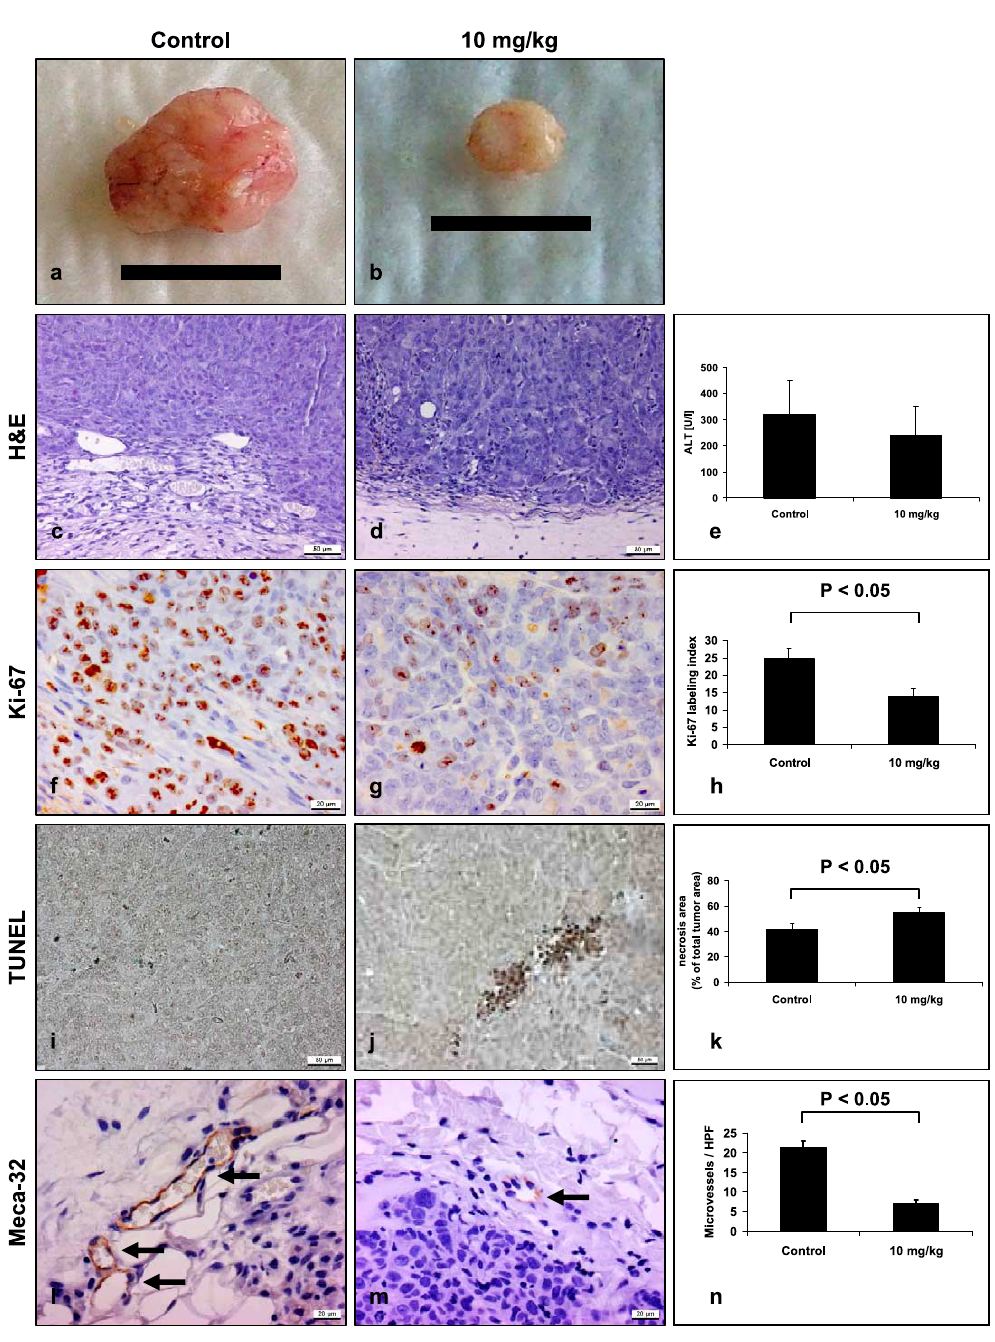
Fig. 6. Morphologic analysis of HepG2 xenografts treated with panobinostat. Representative tumors are shown from vehicle treated controls (a) or animals receiving daily i.p. injection of 10 mg/kg panobinostat for 30 days (b) and related H&E stainings (c, d). Bar in (a) and (b) is 1 cm. (e) shows mean ALT levels ± SEM of 8 animals/group. Ki-67 stainings (f, g) showed a significant reduction of the proliferation index (h) in panobinostat treated animals, paralleled by an increase in TUNEL positive cells (i, j) and total necrosis area (k). Endothelial cell stainings with the Meca-32 antibody (arrows in l and m) revealed a significantly decreased microvessel density (n) after panobinostat treatment. Results in (h), (k) and (n) are mean ± SEM of 4 independent high power fields of sections of 8 animals/group. Magnification is 200 × for (c, d) and (i, j) and 400 × for (f, g) and (l,